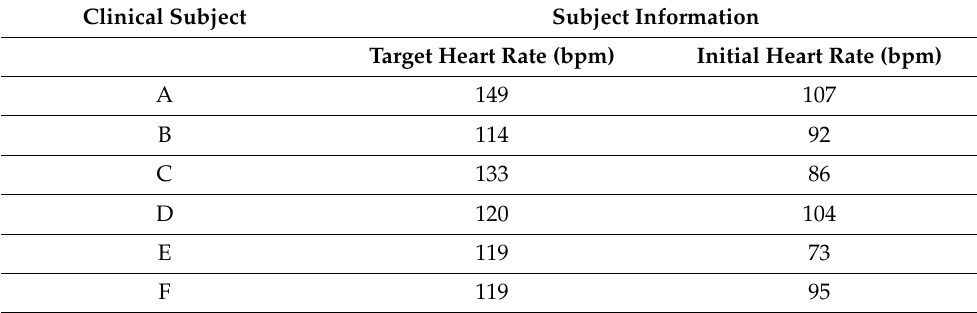
Table 5. Target heart rate of each clinical subject (prescribed by a